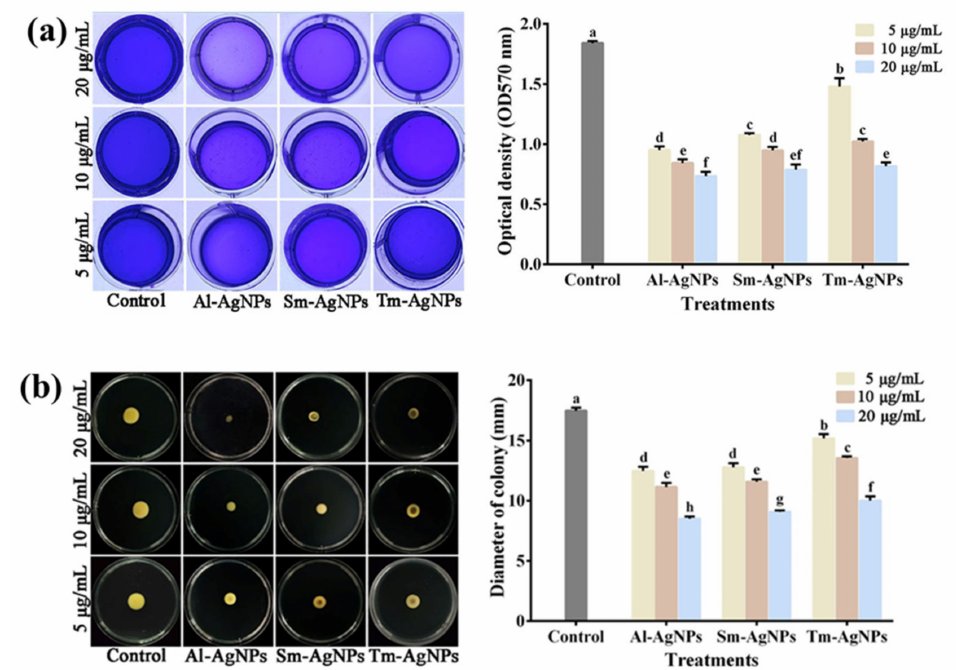
Figure 5. Inhibition of Al-AgNPs, Sm-AgNPs and Tm-AgNPs on biofilm formation and swimming motility of Xoo strain C2. ( a ) The inhibition of biofilm formation. ( b ) The inhibition of swimming motility. Error bars showing the mean of three replicates (n = 3 ± standard deviation). Different lowercase letters on the bars are represent the signifcantly different at p ≤